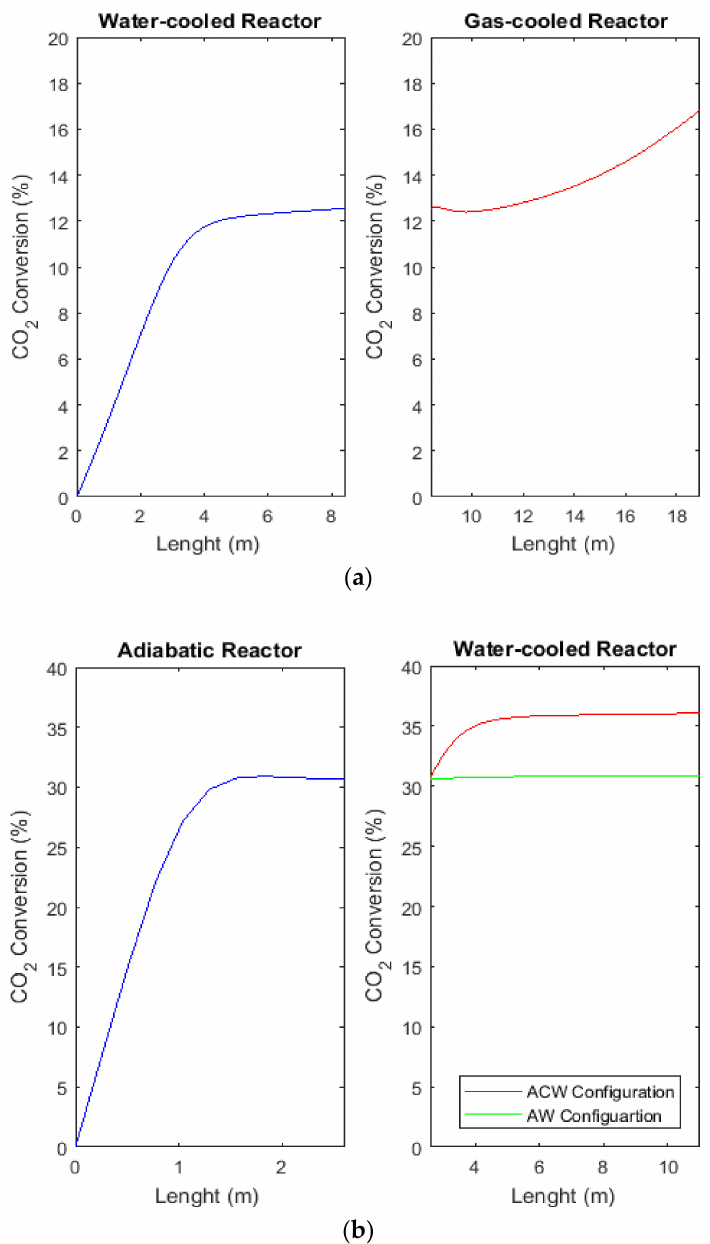
Figure 8. CO 2 conversion along reactors in ( a ) CR configuration; and ( b ) AC and ACW